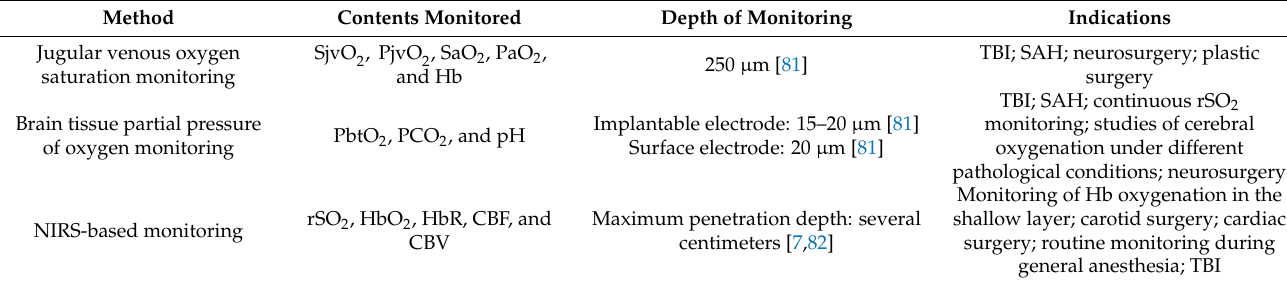
Table 1. Overview of common methods for cerebral blood oxygen saturation monitoring.